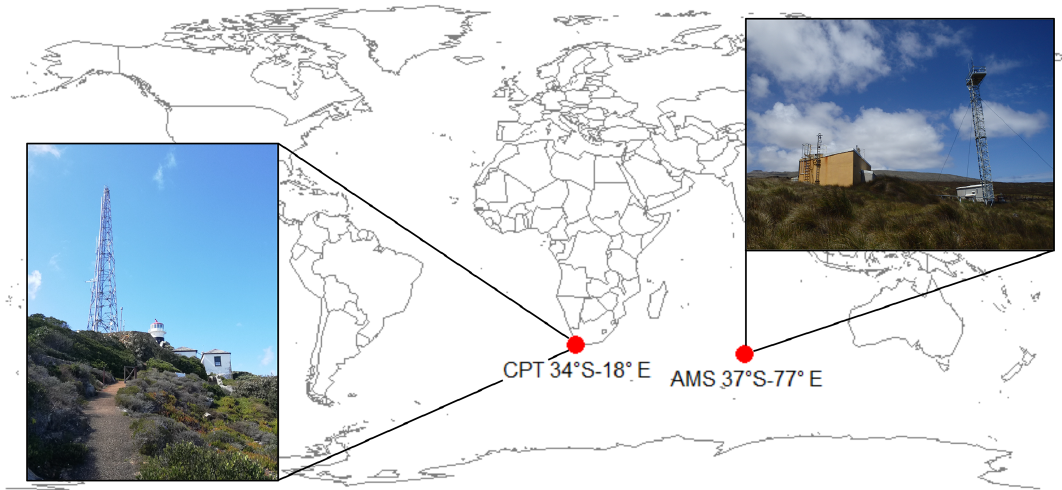
Figure 1. Location of the Cape Point (CPT) and Amsterdam Island (AMS) stations.